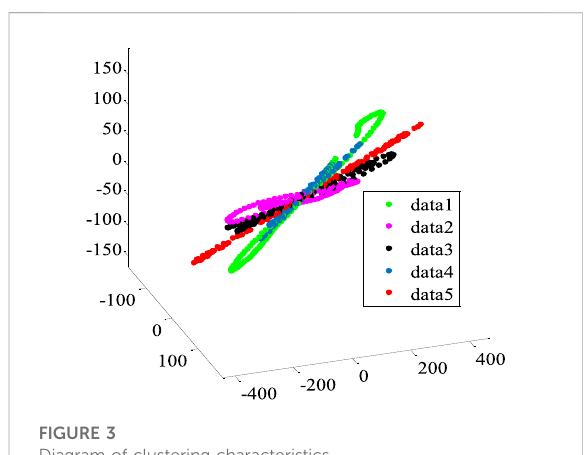
FIGURE 3 Diagram of clustering